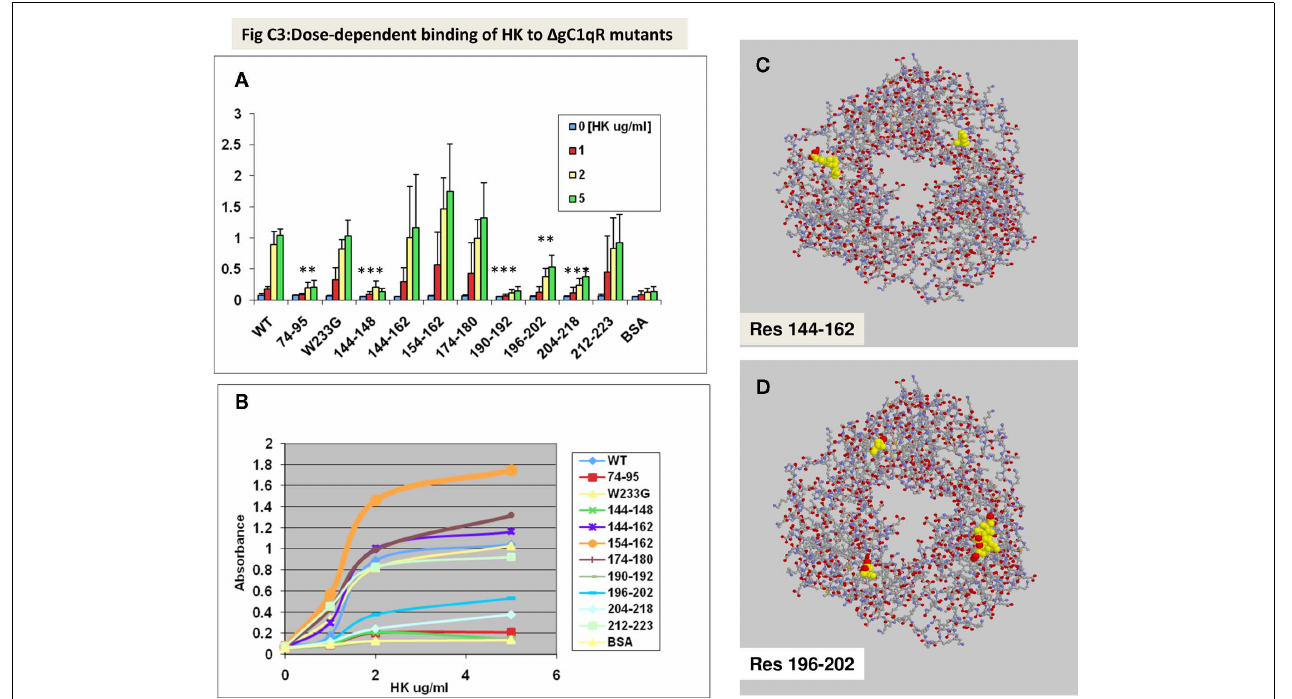
FIGURE 1 | Binding of HK to gC1qR mutants using solid-phase microplate assay. Duplicate wells of microtiter plates were first coated with 100 μ l (2 μ g/ml) of wild type or gC1qR mutants ( Δ gC1qR). After the unreacted sites were blocked, concentrations of HK were added as indicated.The